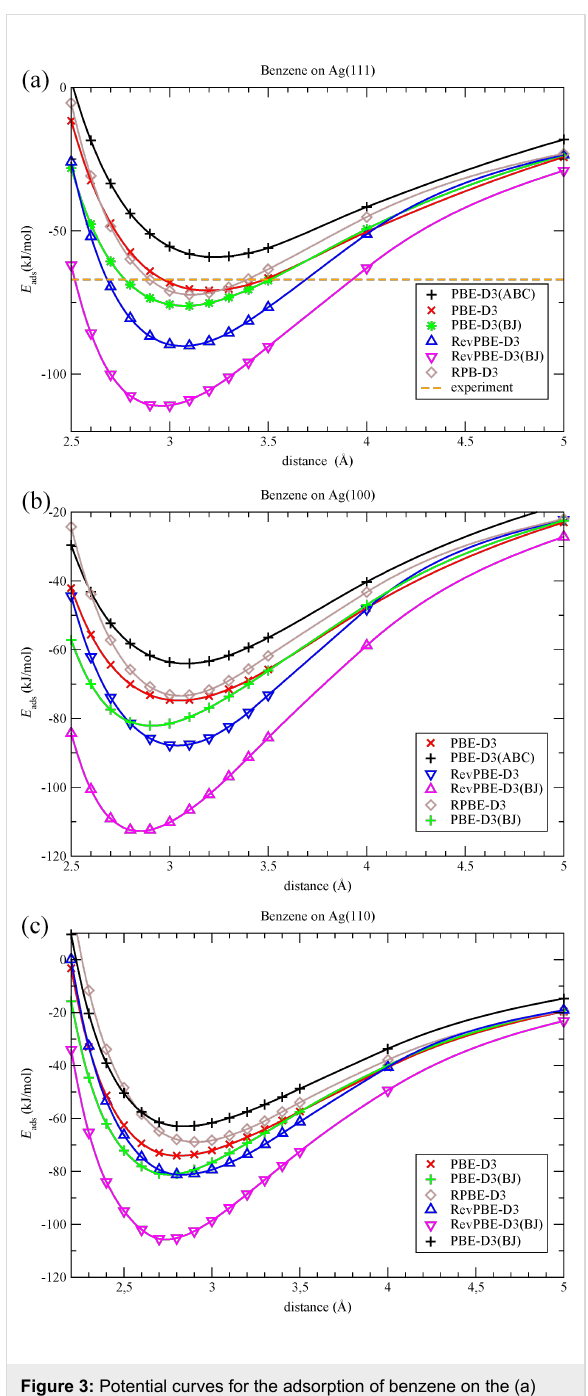
Figure 3: Potential curves for the adsorption of benzene on the (a) Ag(111), (b) Ag(100), and (c) Ag(110) surfaces.